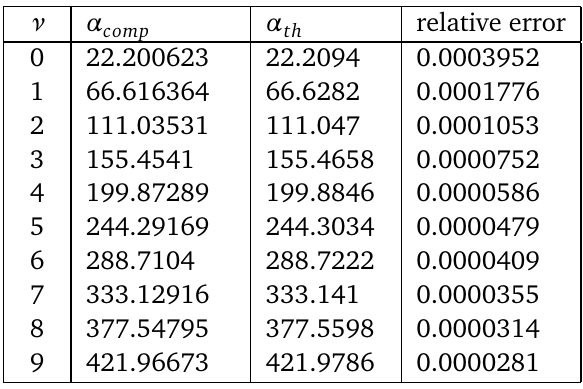
Table 1: Comparison of the eigenvalues obtained from numerical computation (col- umn two) and theory (column three) for constant magnetic fields ( n = 0) with = 10 15 G pm − n B 0